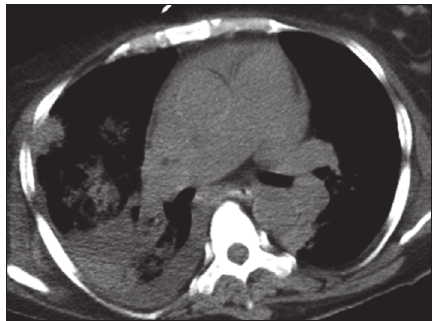
Figure 4: CT scan of the chest, depicting wedge shaped large pulmonary infarct.